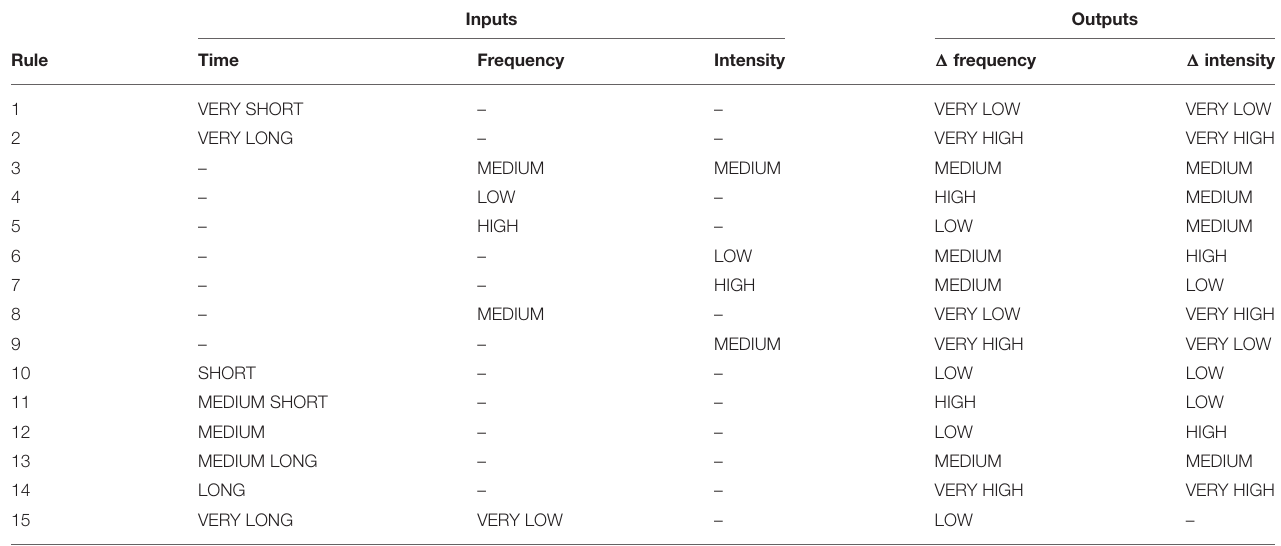
TABLE 4 | Fuzzy rules for the single particle sound synthesis example. Inputs Outputs